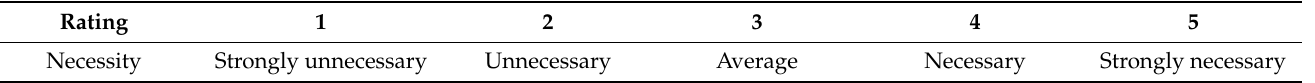
Table 3. Relationship between rating and